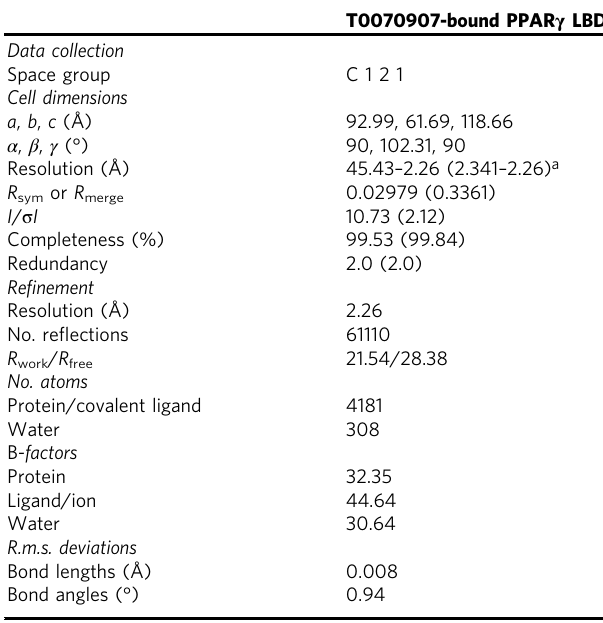
Table 1 X-ray crystallography data collection and re fi